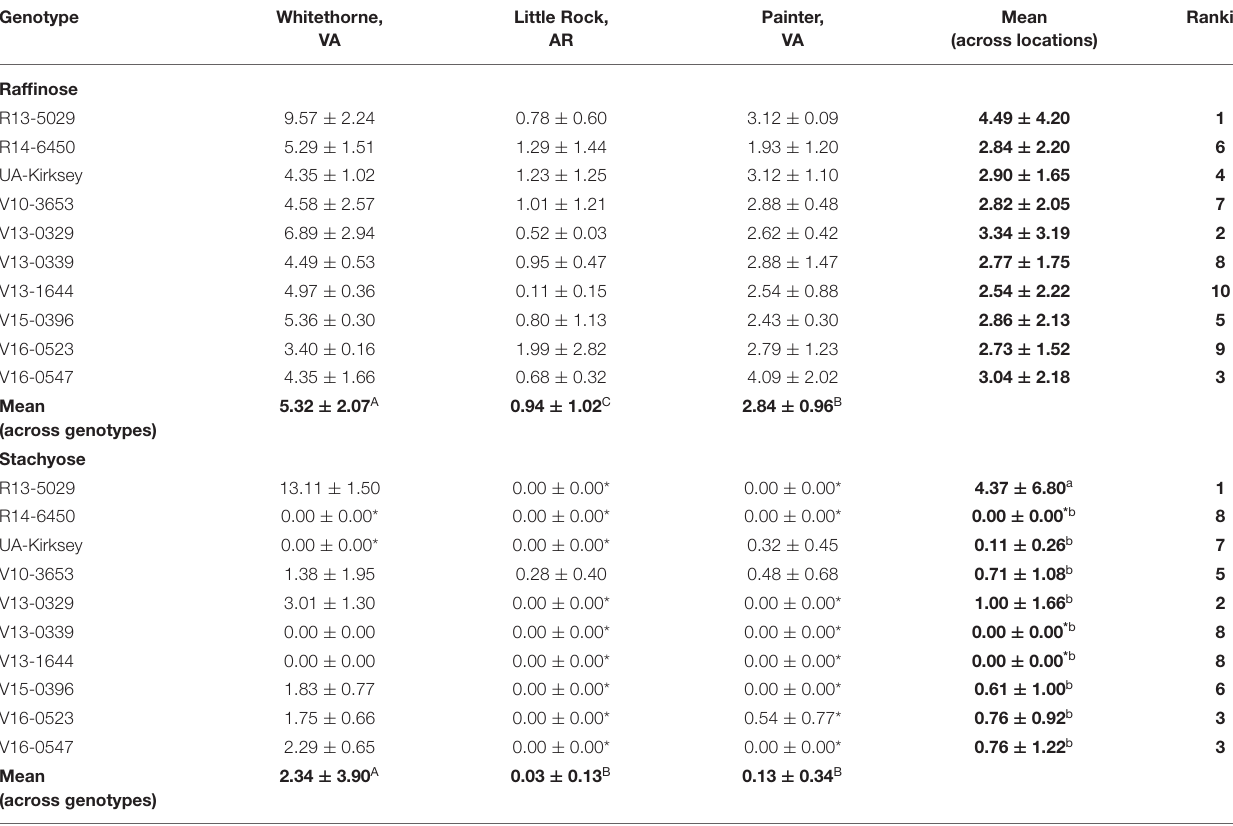
TABLE 5 | Raffinose and stachyose contents (mg/g dry matter) of 10 edamame genotypes planted in different locations. Genotype Whitethorne,